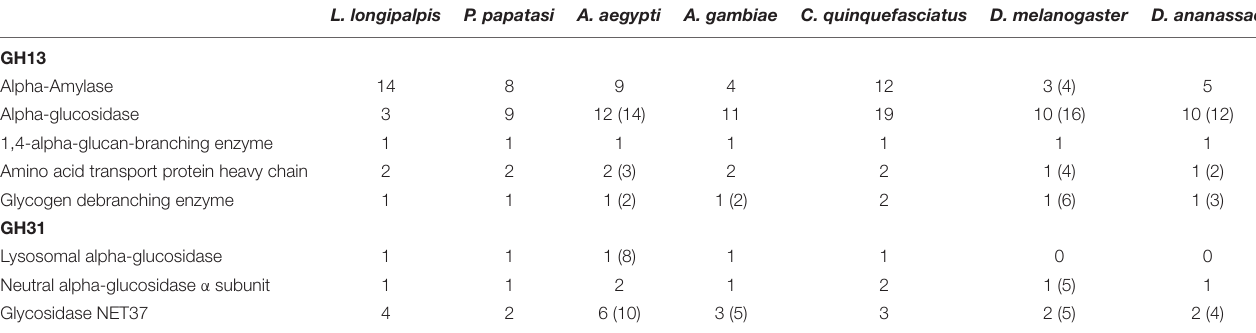
TABLE 3 | Comparison of GH13 and GH31 gene numbers retrieved from Vector Base, Fly Base and NCBI in different dipteran